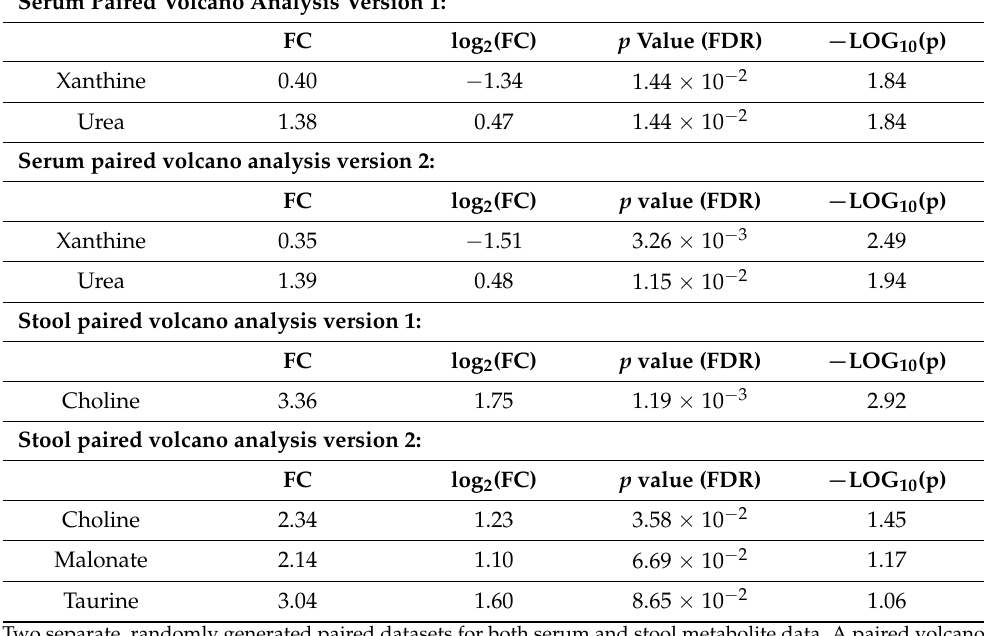
Table 2. Paired volcano analysis of serum and stool metabolite profiles obtained from the v.1 and v.2 list of FD patient–relative control